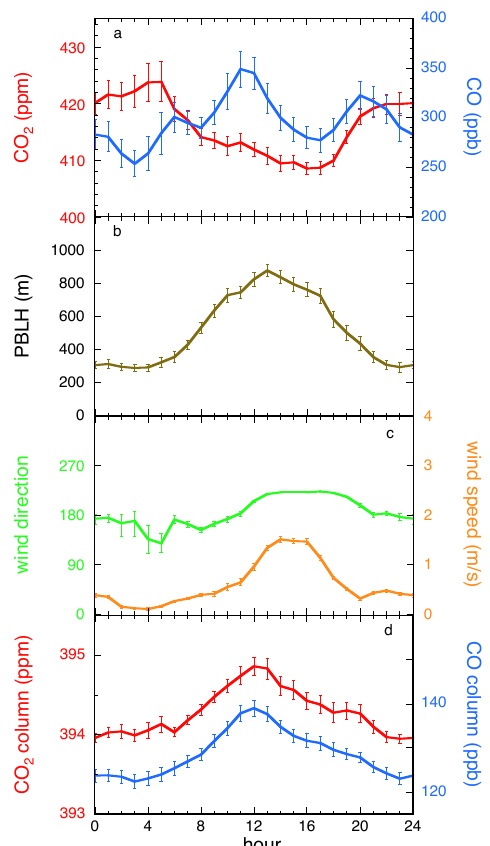
Fig. 3. Average diurnal patterns for (a) measured CO 2 and CO, (b) boundary layer height, (c) wind speed and direction for non-calm periods, and (d) CO 2 and CO in the atmospheric column, after cor- recting the measured values for changes in boundary layer height. Wind directions are plotted with north = 0 ◦ and 360 ◦ ; east = 90 ◦ ; south = 180 ◦ ; and west = 270 ◦ . Error bars indicate standard devi- ations of the means ( n =